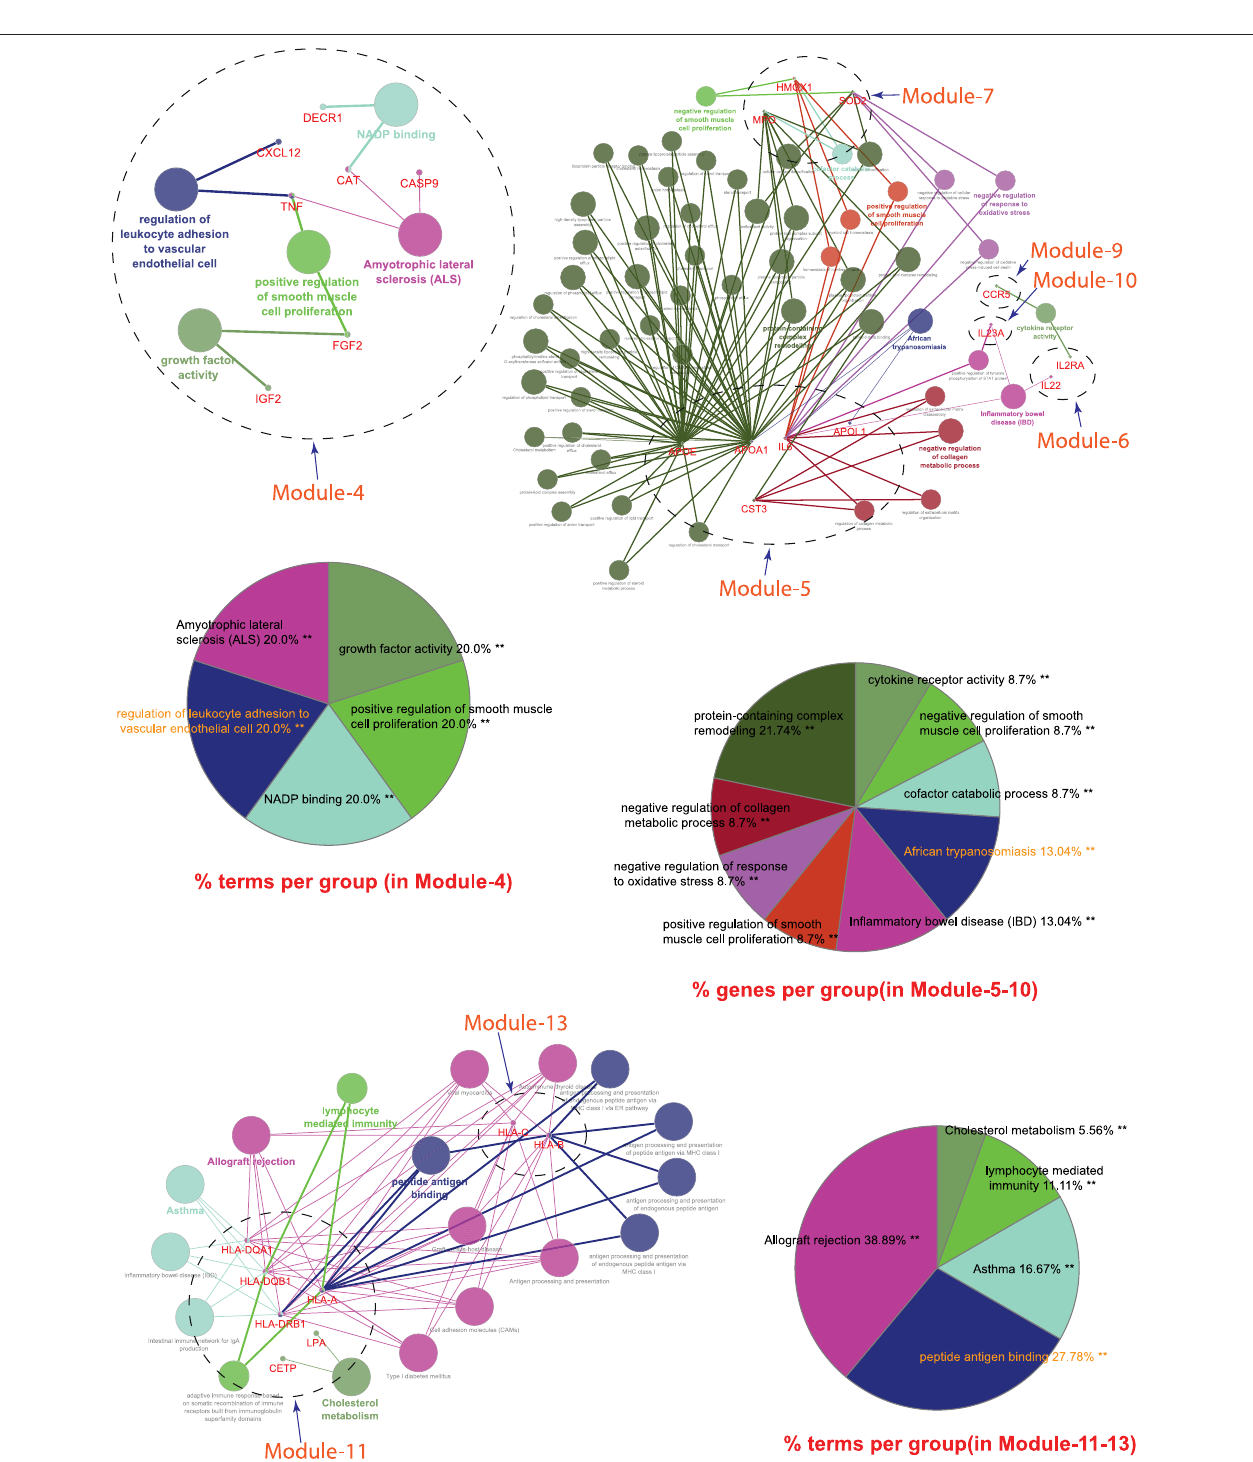
FIGURE8| GOenrichmentAnalysis:Networkrepresentationshowsthevariousbiologicalprocessesandpathwaysenrichedbygenesofmodule-4tomodule-13. Each node representsapathway andbiologicalprocess. Thenode sizere fl ectstheenrichmentsigni fi cance ofpathway andbiologicalprocesses. Nodecolorshows the class that they belong to. Mixed coloring means that the particular node belongs to multiple classes.